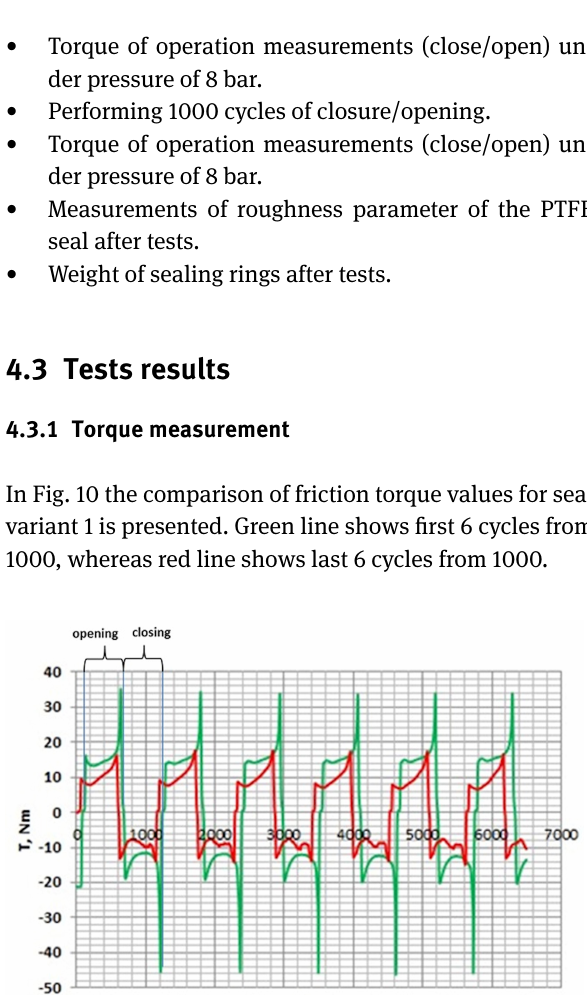
At the beginning of the test the value of the friction torque equaled 35.6 Nm was characteristic for opening and 46 Nm for closure operation. Much lower value was ob- tained after 1000 cycles. In final cycles the friction torque at opening was equal to 16.2 Nm and to 18.8 Nm during clo- sure operation.